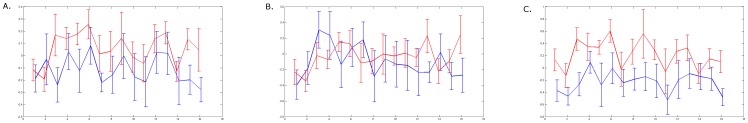
Gender differences in detectors in response to Female Fear, broken down for right amygdala subdivisions.
Females' responses are shown in red, and males' responses are shown in blue.
Left: latero-basal (RA-LB); Center: centro-medial (RA-CM);
Right: superficial (RA-SF).